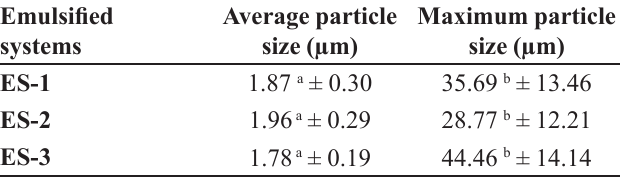
systems, measured by optical microscopy